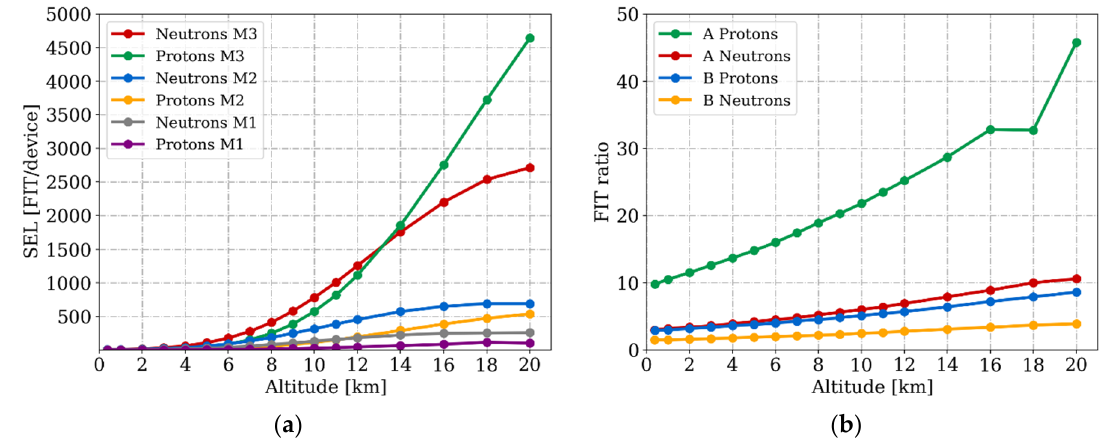
Figure 5. ( a ): Failure in time (FIT)/dev rate for the Alliance memory calculated from M1, M2 and M3 for protons and neutrons. ( b ) Alliance FIT ratio between different methods for neutrons and protons. A = M3/M1, B = M3/M2. The ratio represents the underestimation factor.